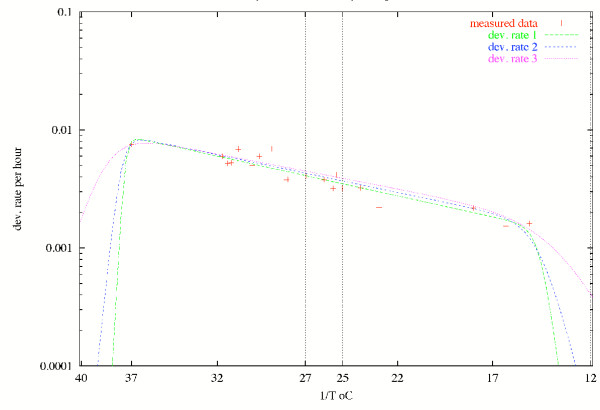
Three possible curves fit to An. gambiae larvae development rate data.